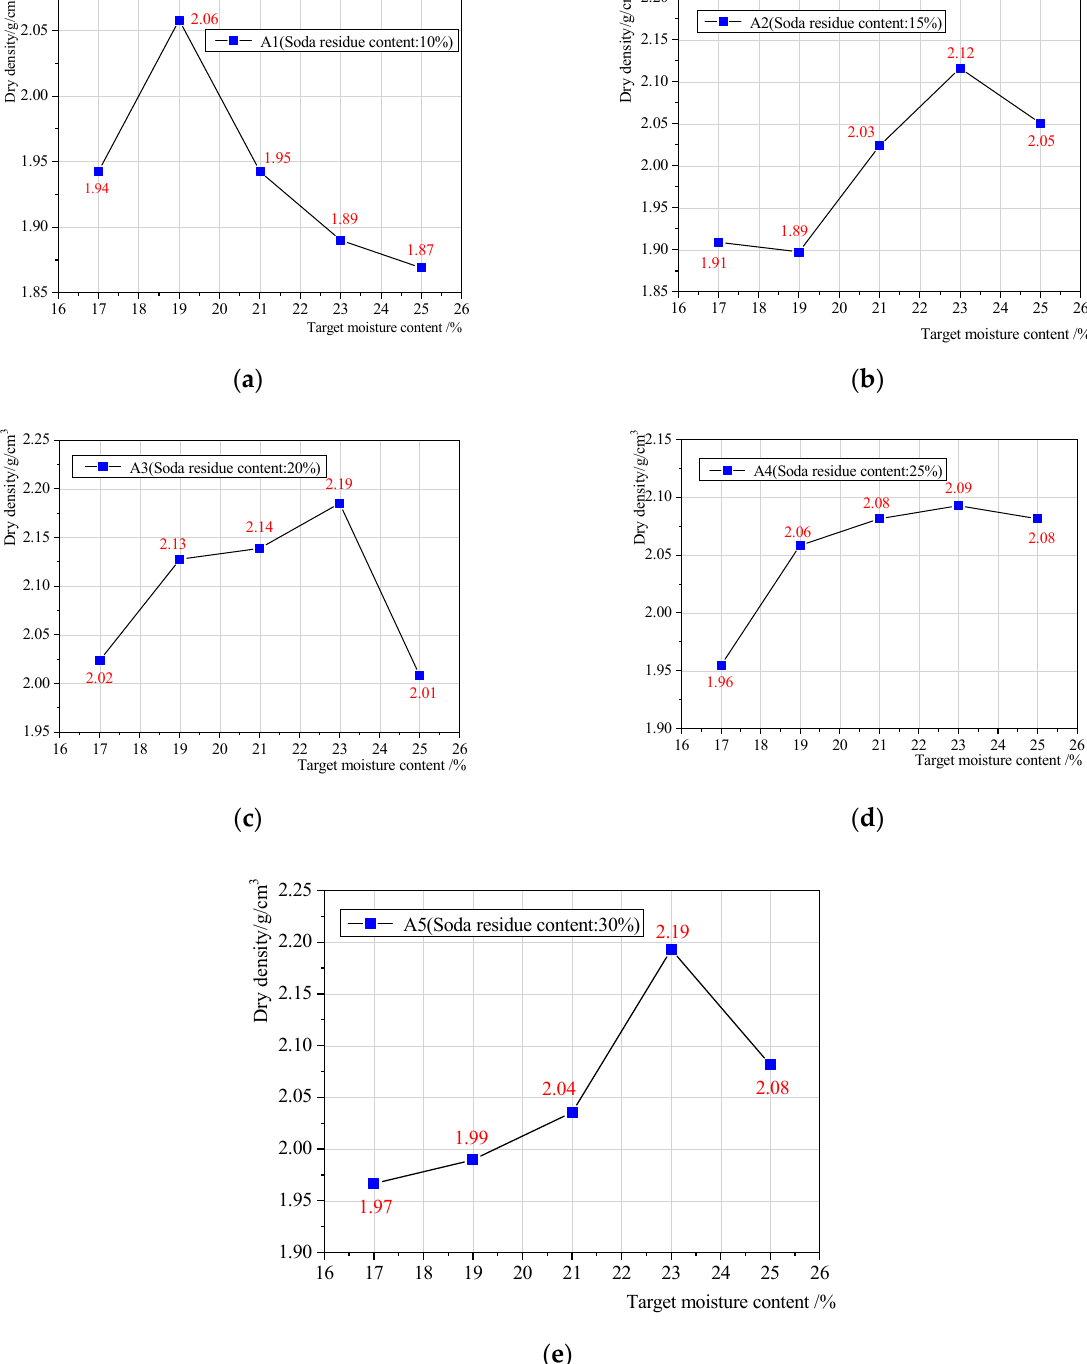
Figure 4. Moisture content–dry density curve. ( a ) SR content: 10%; ( b ) SR content: 15%; ( c ) SR content: 20%; ( d ) SR content: 25%; ( e ) SR content: 30%. Analysis in Figure 4 shows that under the same SR content, with the increase in the target moisture content, the dry density of LSMHCSR in different groups first increases and then decreases. For this reason, after the moisture content in LSMHCSR exceeds the optimal moisture content, the excess water no longer reacts and exists in the form of free water. The free water prevents the material densification at the time of compaction, re- sulting in decreased dry material per unit volume and small relative density of water, so the dry density of LSMHCSR becomes smaller.